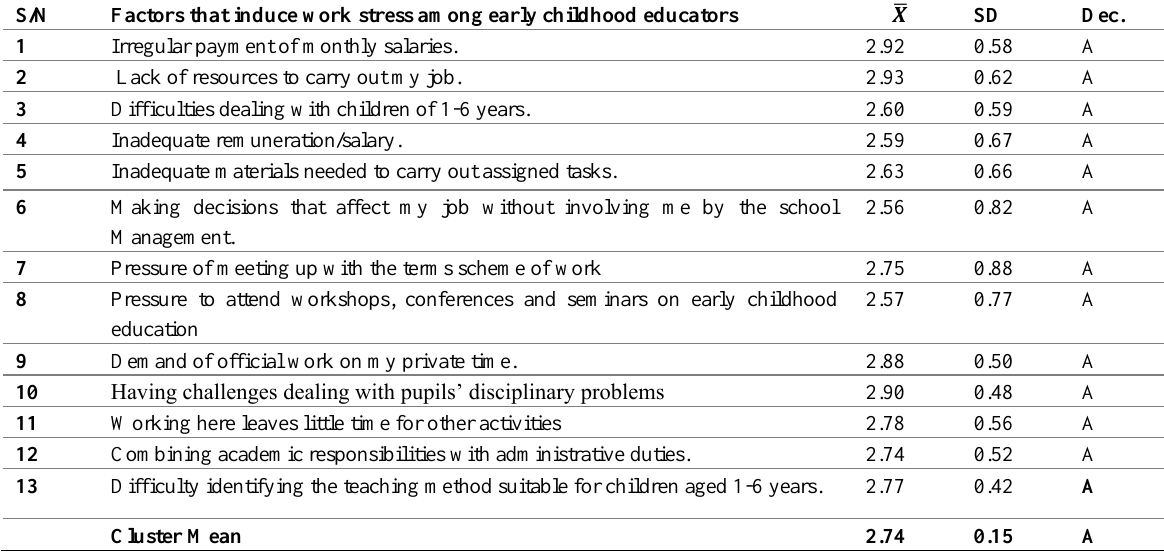
Table 1: Mean and Standard Deviation of respondents on the Factors that induce work stress among early childhood educators S/N Factors that induce work stress among early childhood educators